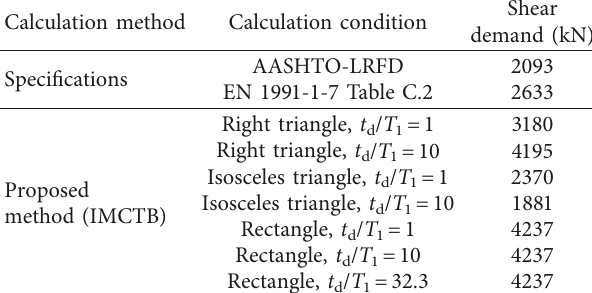
Table 4: Shear demands of bridge columns under impact load based on different calculation